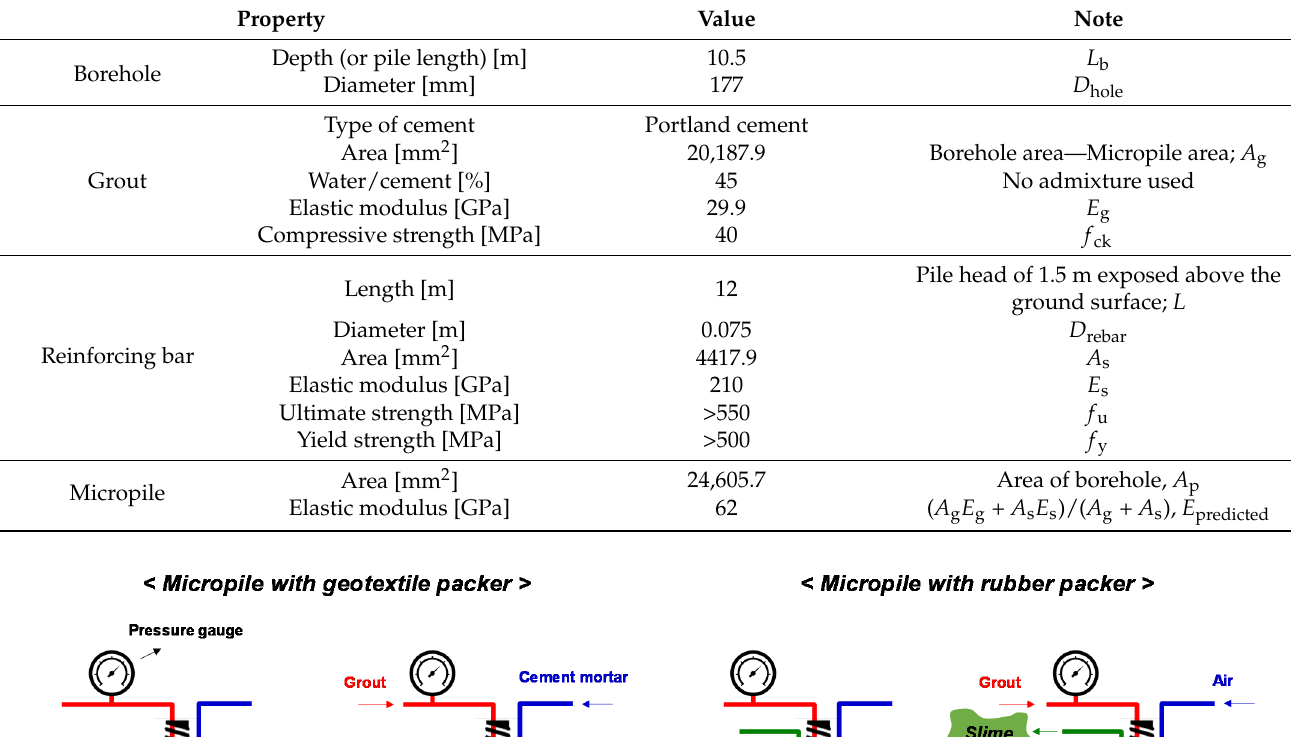
Table 2. Material properties of micropiles.